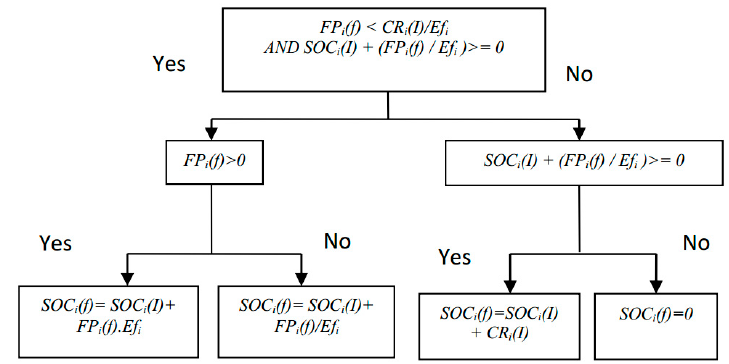
Figure 4. Battery state of charge calculation after performing ancillary services.